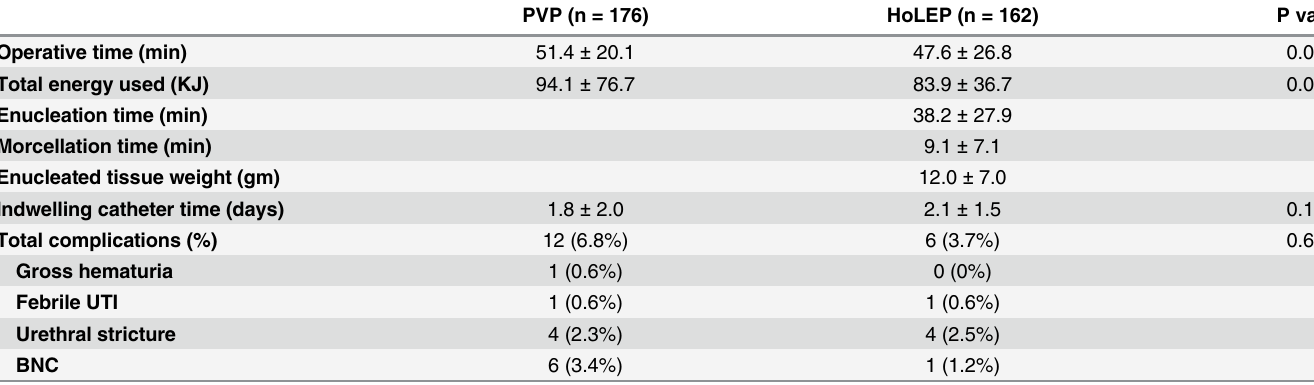
Table 2. Perioperative data and adverse events in patients with small prostate volume undergoing PVP or